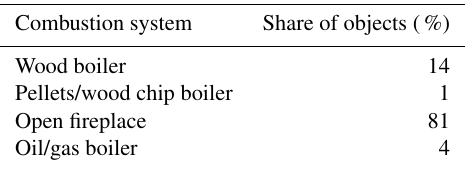
Table A1. Share of each combustion system type from chimney sweeper data in the municipalities of Danderyd, Stockholm, Täby, Värmdö, Vaxholm, Vallentuna and Österåker.